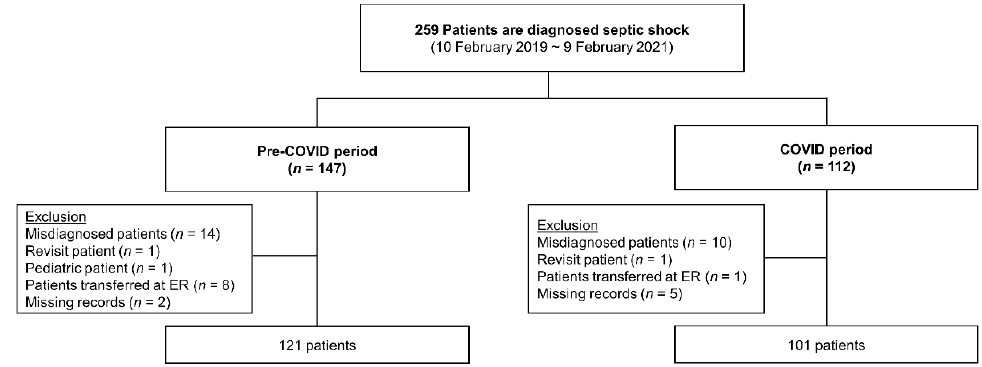
Figure 2. Flow chart of patients enrolled from the NEDIS. Acronyms: NEDIS, National Emergency Department Information System; COVID-19, coronavirus disease; and ER, emergency room.